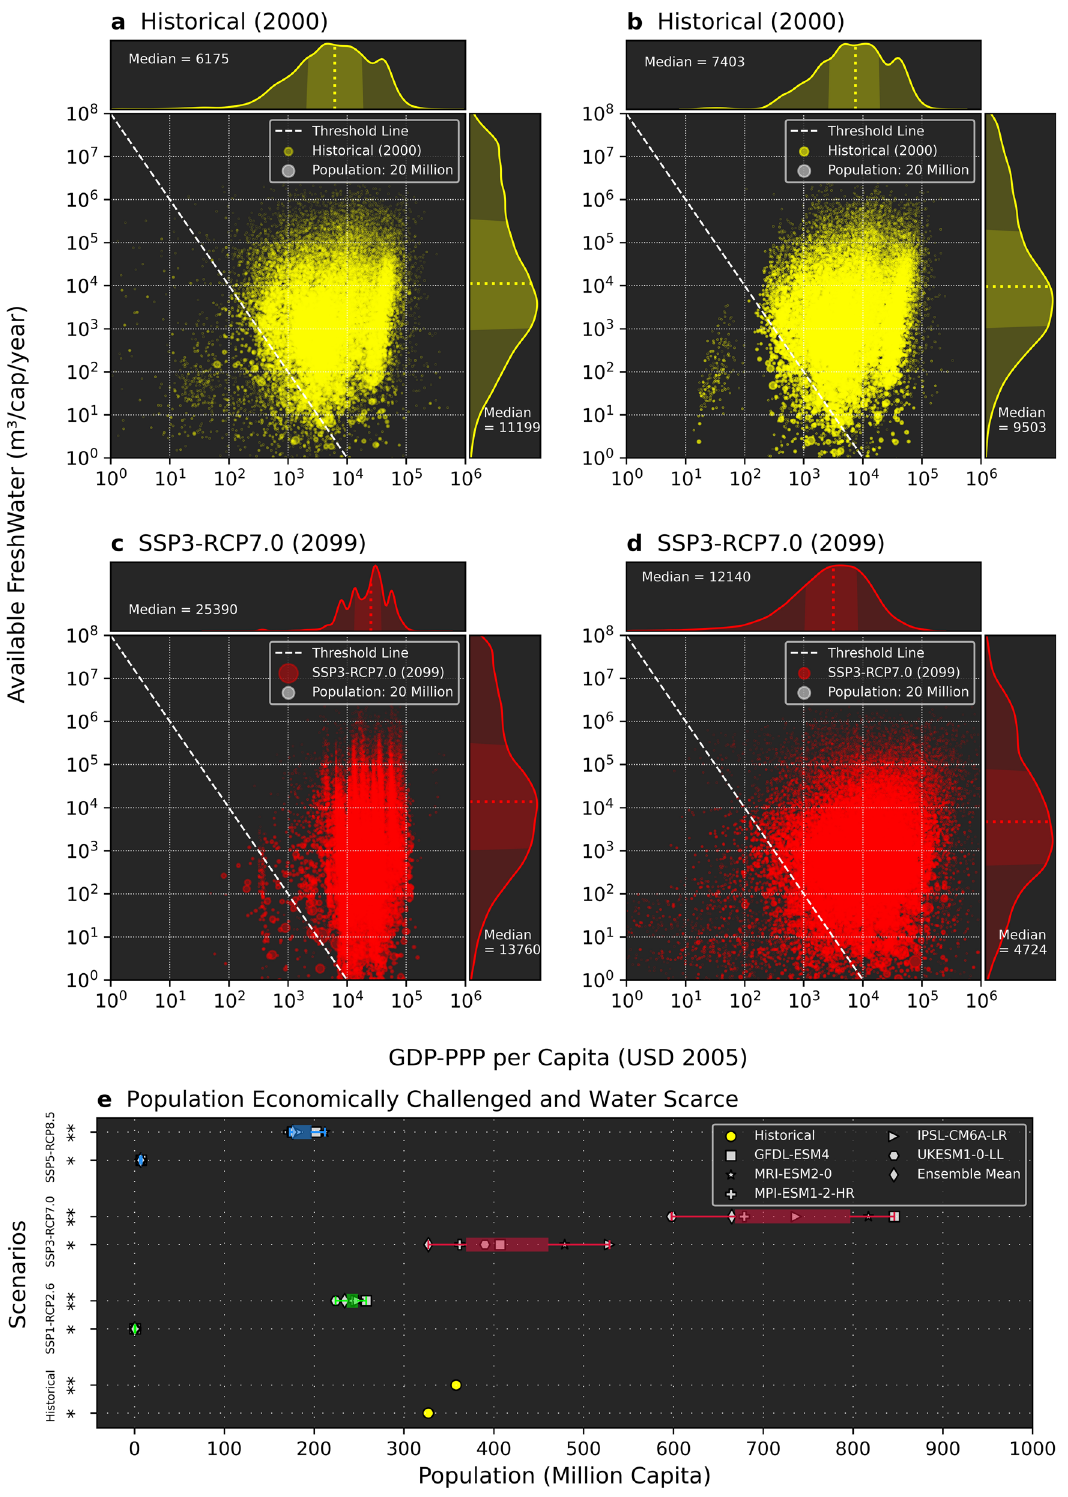
Fig. 2 Grid-level scatter plots for APC vs GDP-PPP per capita and density plot considering the number of grids. ( a ) Historical-GPW, ( b ) Historical- HYDE, ( c ) Future370-MY19, and ( d ) Future370-JO16 scenarios. Grid values are represented as circles, and the dashed line represents the threshold line proposed by Oki et al. 19 . The density plot includes dotted coloured lines (lime and red) for the median and dark shading for the interquartile range ( fi rst and third quartiles). The white circle represents the grid size of 20 million population. e Boxplot for the total population facing physical and economic water scarcity (grids below the threshold of Eq. 1) for all considered scenarios. Legend symbols represent the analysis using the discharge considering various GCMs and the ensemble mean of discharge considering all GCMs. *analysis for Historical-GPW and Future-MY scenarios, **analysis for Historical-HYDE and Future-JO scenarios (Supplementary Table 1 for scenarios/ experiment settings, and Supplementary Table 5 for water-scarce population and uncertainty